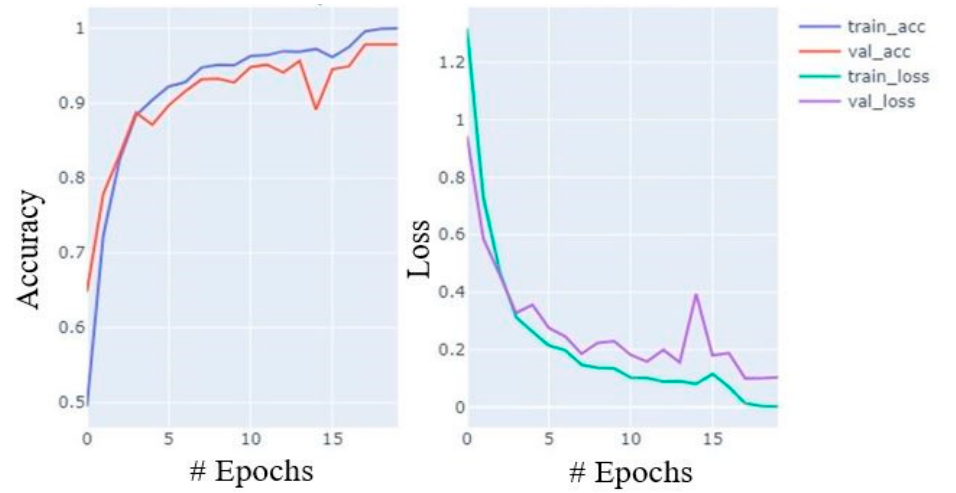
Figure 7. Accuracy and loss plot during training process with training and validation data. Table 4. Class-wise accuracy, precision, recall, and f1-score obtained by the model.